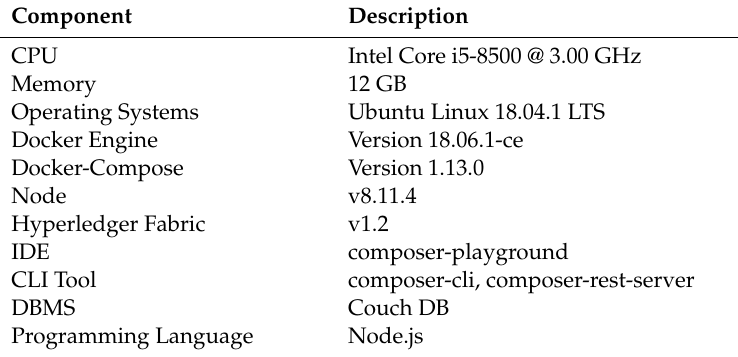
Table 1. Development environment for the IoT blockchain network.